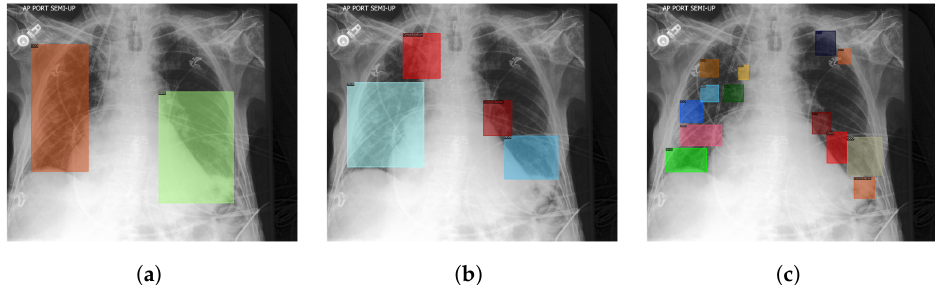
Figure 14. Differences among physicians annotating the same CXR. ( a ) Physician 1 (H). ( b ) Physician 2 (T). ( c ) Physician 3 (D).